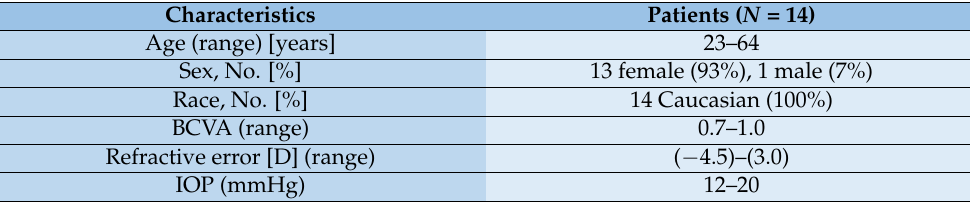
Table 1. Demographic and clinical characteristics of patients with